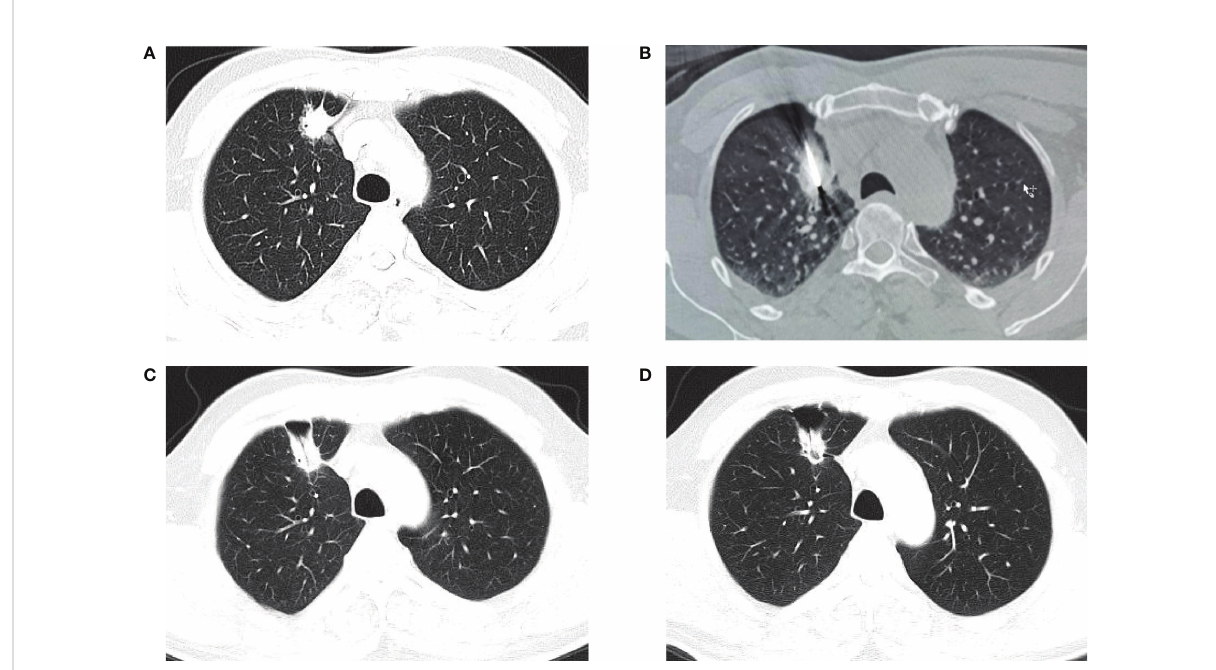
FIGURE 3 CT-guided percutaneous MWA. (A) CT scan performed before MWA, showing a lesion in the upper right lobe. (B) CT − guided percutaneous MWA of the lesion. (C) CT scan performed 1 month after the procedure. (D) CT scan performed 4 months after the